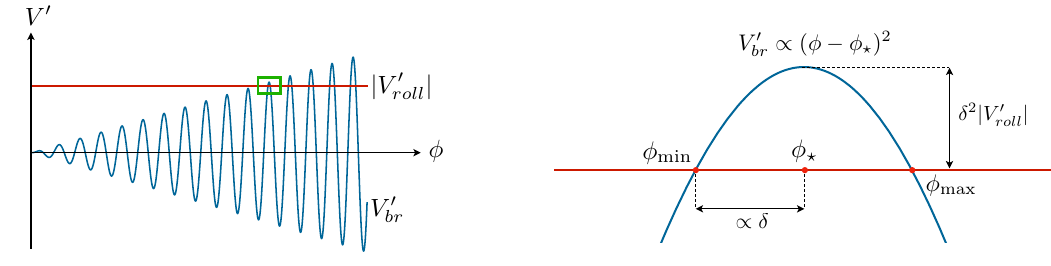
Figure 1 . Schematic picture of the slope of relaxion potential in the neighbourhood of the (cid:12)rst local minimum (left panel), and zoomed in around the (cid:12)rst minimum (right panel), with the Higgs (cid:12)eld set to the minimum of its potential. The (cid:12)rst relaxion minimum is reached when the slope of the rolling potential (red line) is balanced by the slope of the periodic barriers (blue line). (cid:30) min , (cid:30) max , and (cid:30) ? are the positions of the (cid:12)rst minimum, the (cid:12)rst maximum, and the in(cid:13)ection point of V ,